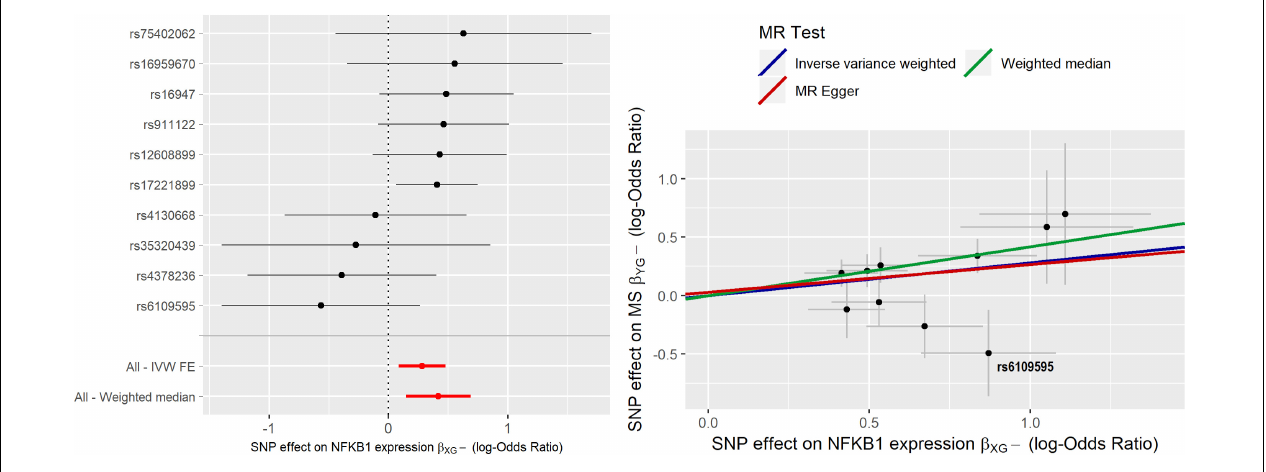
FIGURE 5 | Forest plot and Scatter plot of causal estimates of NFKB1 expression in cerebellum (CRBL) on MS after outlier’s removal.